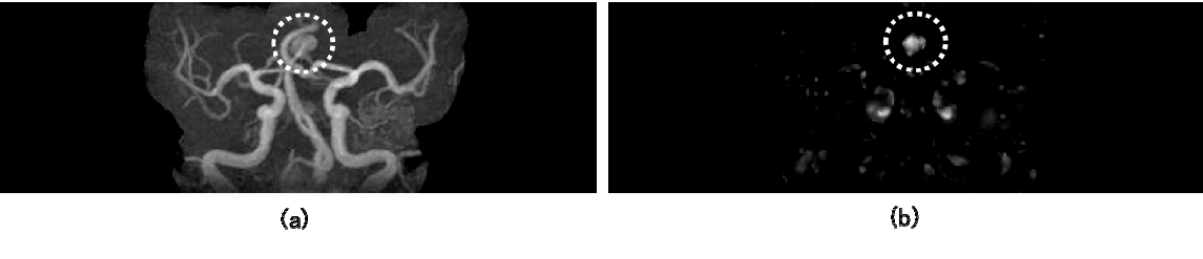
Figure 4. Effect of a dot-enhancement filter for a MRA image with an unruptured intracranial aneurysm: (a) an original MRA image and (b) a dot-enhanced image [25,26].